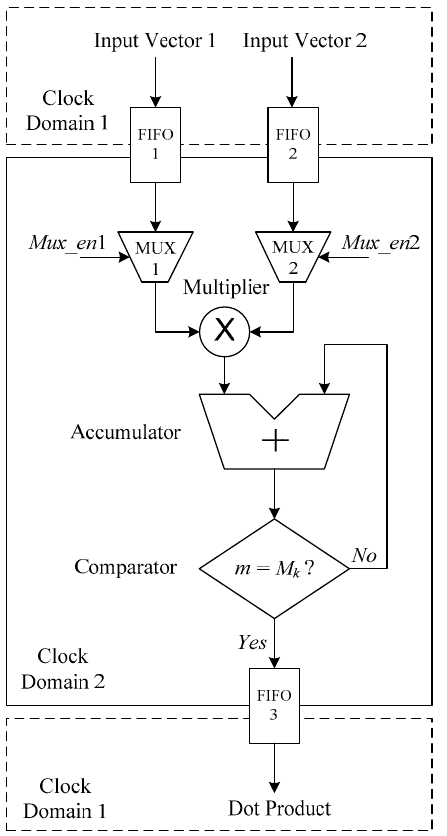
Figure 3. Hardware design block diagram of the dot product computing unit.